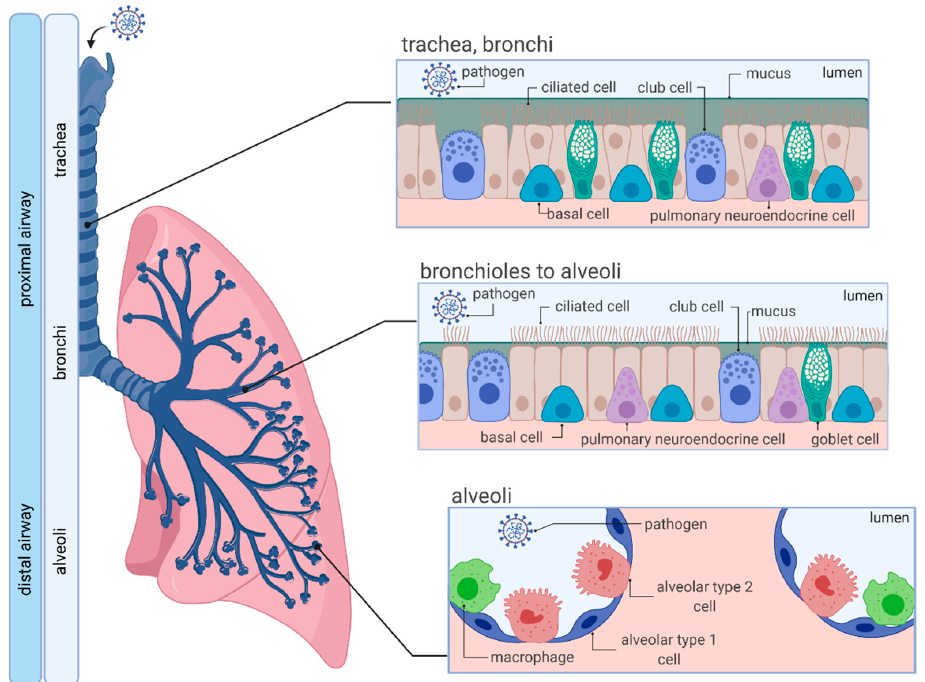
Figure 1. Organization and cellular characteristics of the human respiratory airway. Adapted from “Respiratory Epithelium”, by BioRender.com (accessed on 22 April 2021) (2021). Retrieved from https://app.biorender.com/biorender-templates (accessed on 21 April 2021).